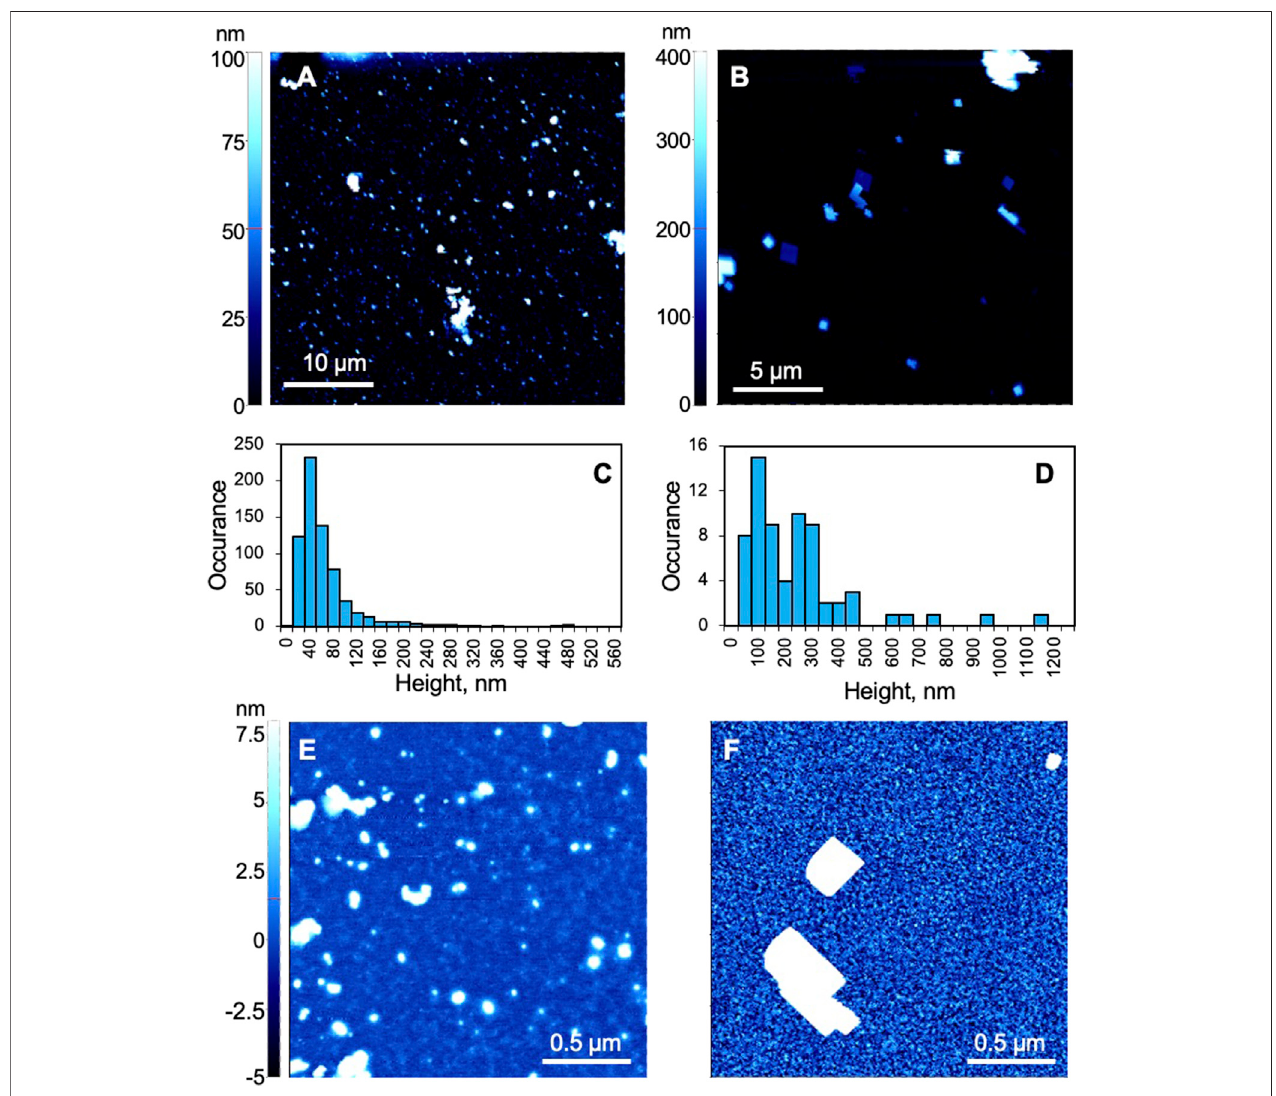
FIGURE 2 | Atomic force microscopy (AFM) characterization of Prussian blue nanoparticles. (A , B , E , F) AFM images of (A , E) type I and (B , F) type II PBNPs. (C , D) Histogramsof (C) typeIand (D) typeIIPBNPs. (C) wasbasedonimagescollectedfromtwo40 μ m × 40 μ mandone30 μ m × 30 μ mareas( N (cid:1) 680),and (D) wasbased on three 20 μ m × 20 μ m areas ( N (cid:1) 67). All AFM fi gures were fi rst-order fl